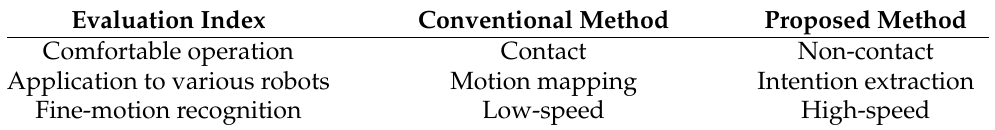
Table 1. Positioning of this